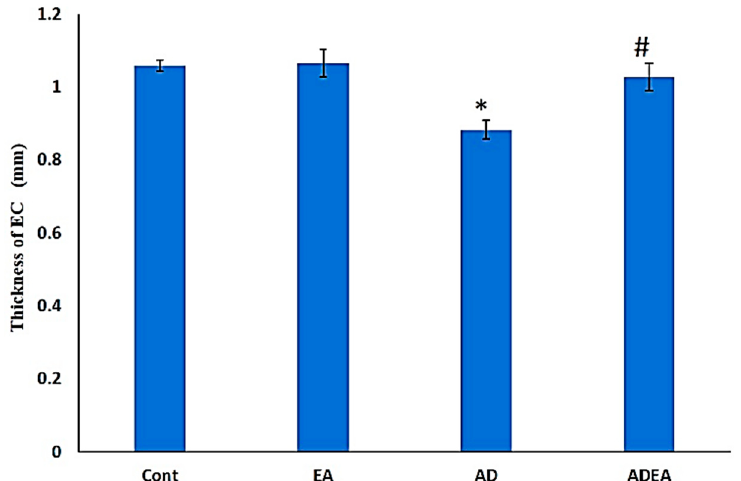
Figure 5. Bar graph showing the ERC thickness (mm) in the groups. Data are presented as the means ± SD. One-way ANOVA was used, and Fisher’s LSD t -test was applied when equal variance could be assumed. * Significantly different from the control, EA, and ADEA groups at p ≤ 0.05. # Signifi- cantly different from the AD group at p ≤ 0.05.